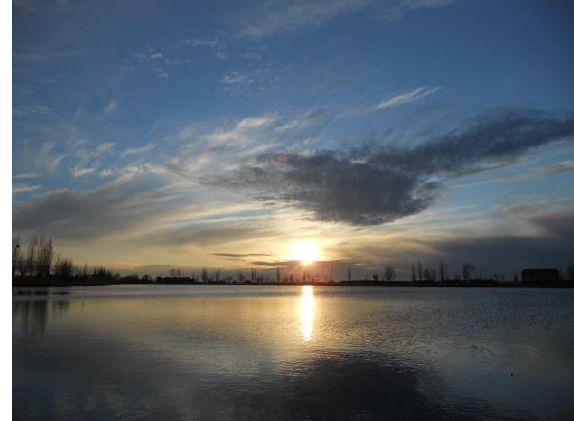
Figure 2. Gambulaga – Portomaggiore (FE), Tramonto Lake.